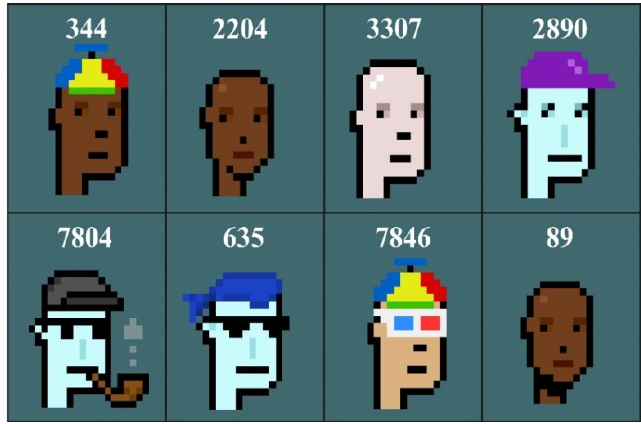
Figure 4: A Sample of Some of the Top 20 Most Valuable CryptoPunks